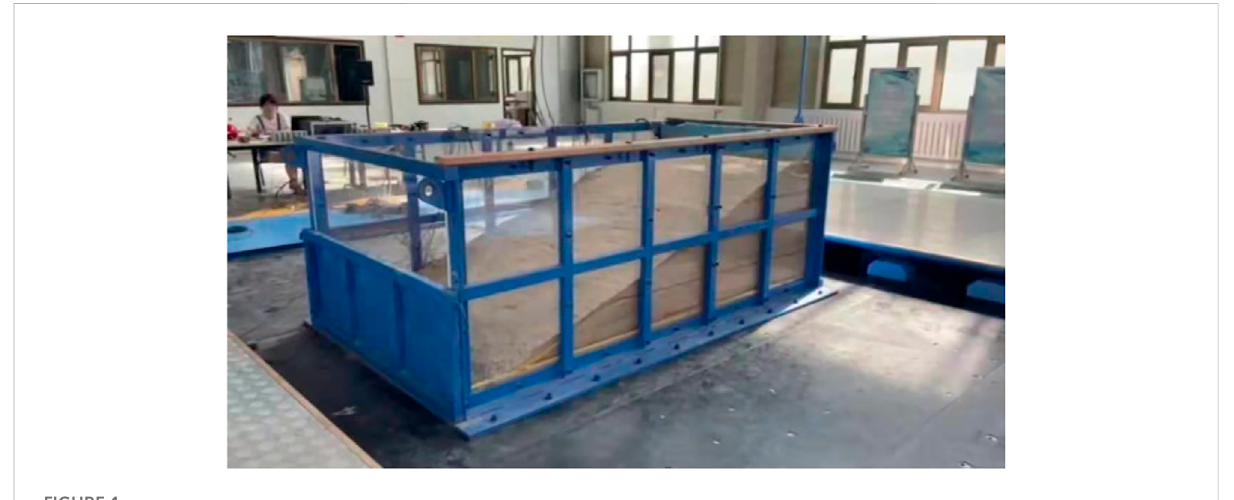
FIGURE 1 Shaking table and model